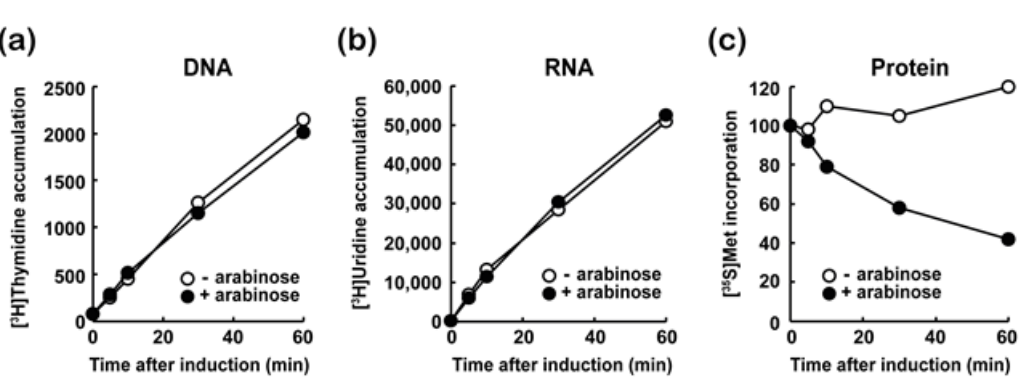
Figure 3. Effect of MazF-at induction on ( a ) DNA, ( b ) RNA, and ( c ) protein synthesis in vivo . The culture harboring pBAD24- mazF-at was grown until the OD 600 nm of the culture reached 0.4, then MazF-at was overexpressed by induction with arabinose to a final concentration of 0.2%. Each 0.4 mL cell culture was sampled at 0, 5, 10, 30, and 60 min after the induction and was mixed with [ 3 H]-thymidine ( a ), [ 3 H]-uridine ( b ), or [ 35 S]-methionine ( c ).